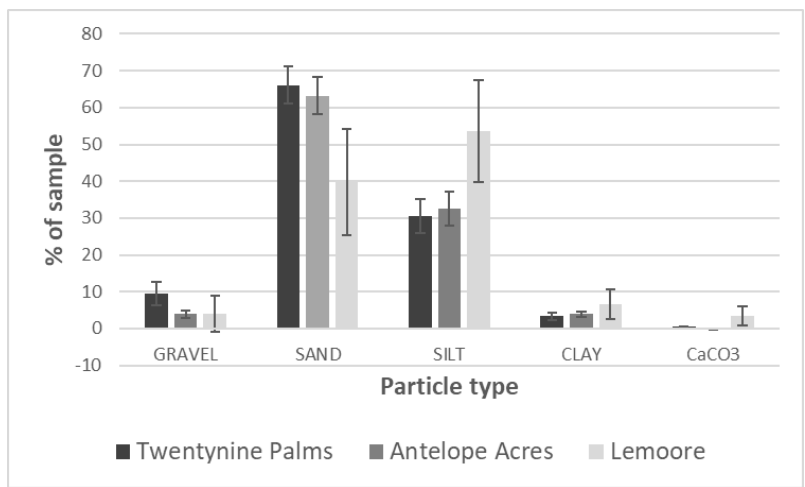
Figure 7. Comparison of grain size analyses of representative soil samples from all three main sampling locations. The graph shows the percentage of each soil particle type in soils from the three locations investigated ( n = 18 for Twentynine Palms, n = 12 for Antelope Acres, and n = 7 for Lemoore sites. Error bars represent 95% Confidence Intervals).